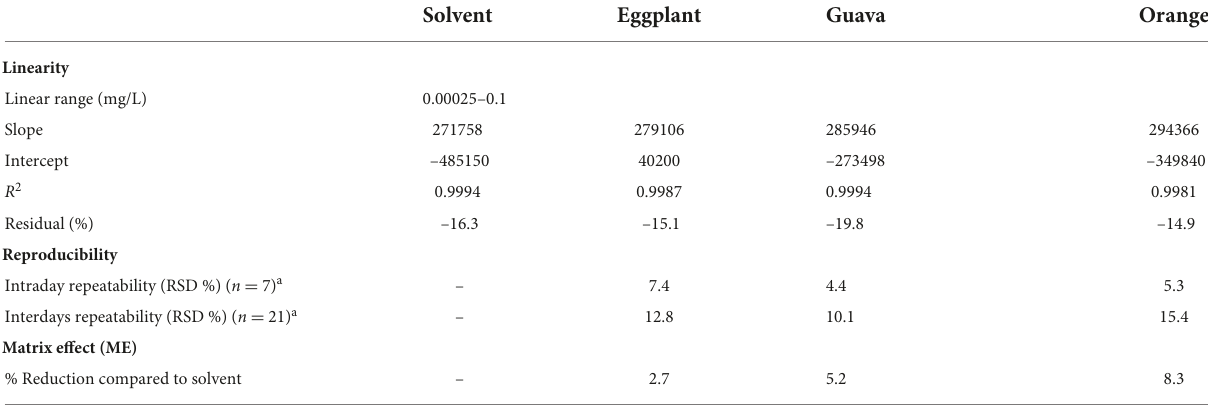
TABLE 2 Linearity, reproducibility, and matrix effect (ME) results from the validation study of fenpyroximate in three commodities. Solvent Eggplant Guava